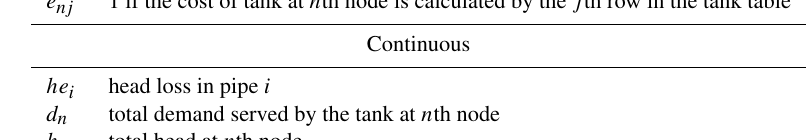
Table 1. Several variables are added to the model to capture the choice of tank configuration. Binary f i flow in pipe i is primary ( = 1) or secondary ( = 0) k si 1 if node s is the source for secondary link i s